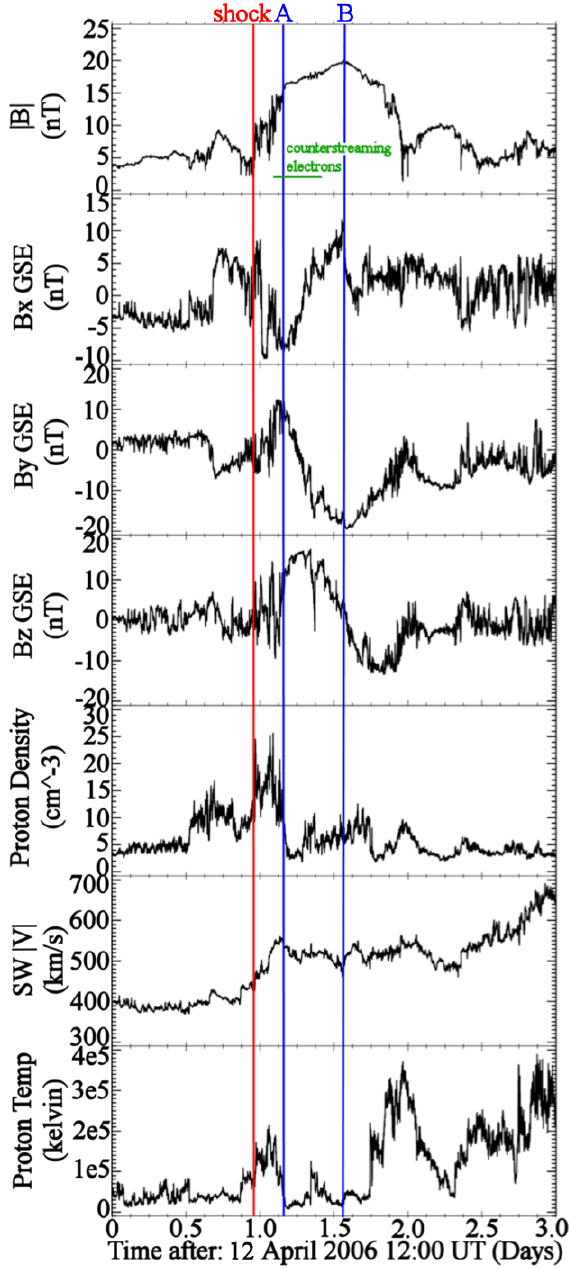
Fig. 1. Interplanetary magnetic field and plasma data obtained from the ACE spacecraft during the passage of the ICME ejecta. We plot the magnetic field intensity, B , and its components in Geocentric Solar Ecliptic (GSE) co-ordinates, proton density, solar wind bulk speed and the proton temperature as a function of time. Vertical lines indicate the arrival of a shock (red) at ∼ 11:00UT 13 April 2006 and the boundaries, A and B, (blue) of the magnetic cloud at ∼ 16:00UT 13 April 2006 and ∼ 01:15UT 14 April 2006, re- spectively. The duration over which counterstreaming, suprather- mal electrons are observed is indicated by the horizontal green line between ∼ 14:30UT and ∼ 22:00UT 13 April